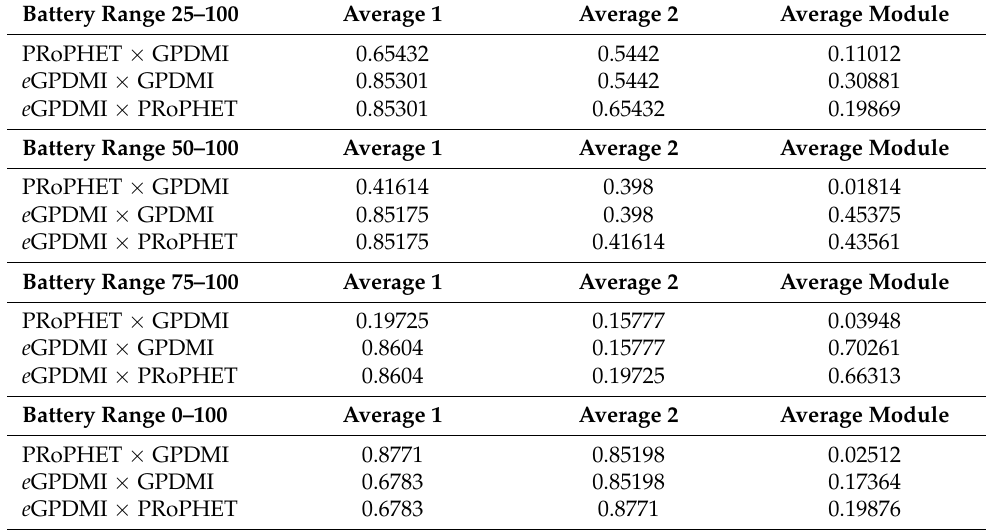
Table 9. Tukey test applied to the ANOVA results obtained in Table 8.